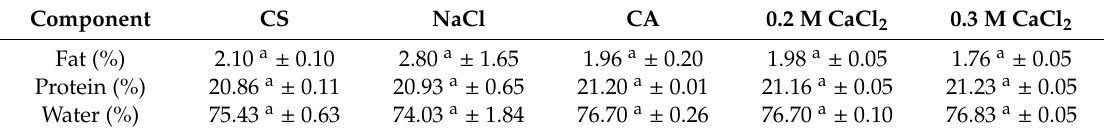
Table 2. Chemical composition of horse meat after 96 h of cold storage (%; x ±